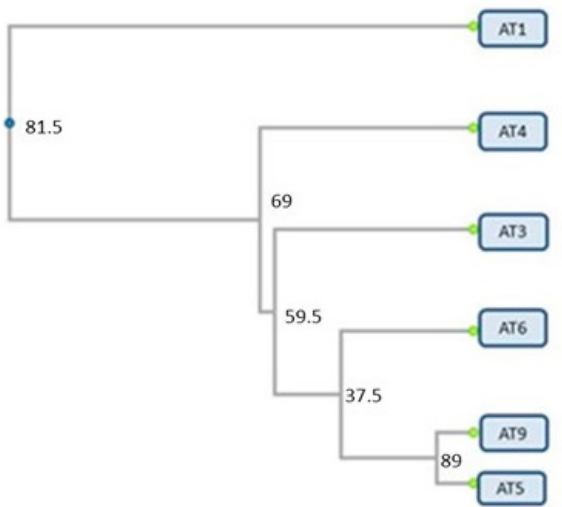
Table 3. Natural populations included in the genetic studies and polymorphism and diversity.